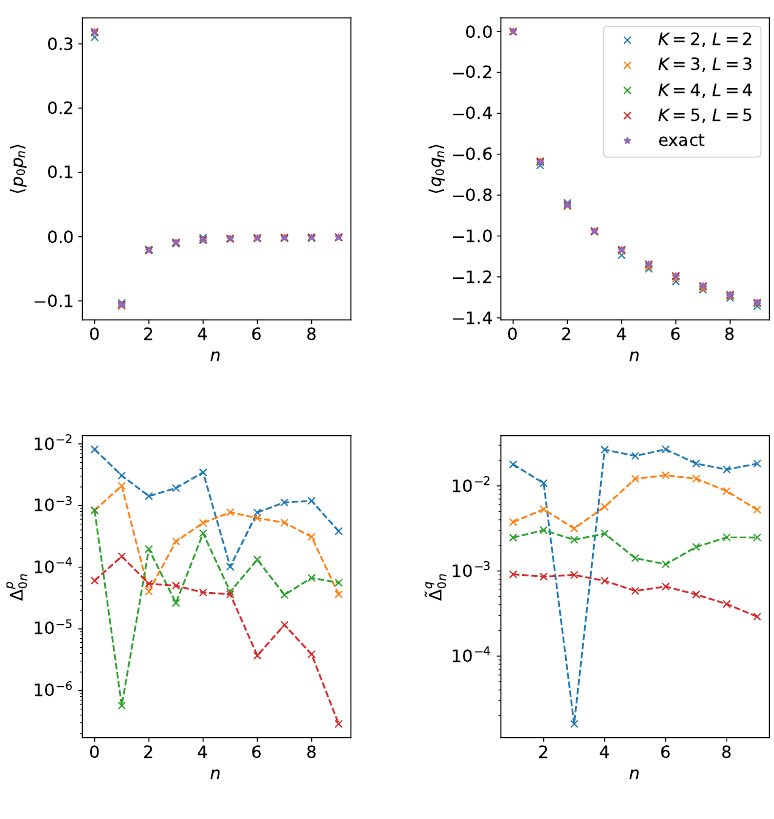
Figure 4: Approximation of correlation functions for the massless harmonic chain by the MERA. We used the filter construction of Appendix B and L = 20 layers of renormal- ization. The former depends on parameters K and L which are explained in the main text. We show the correlation functions 〈 p